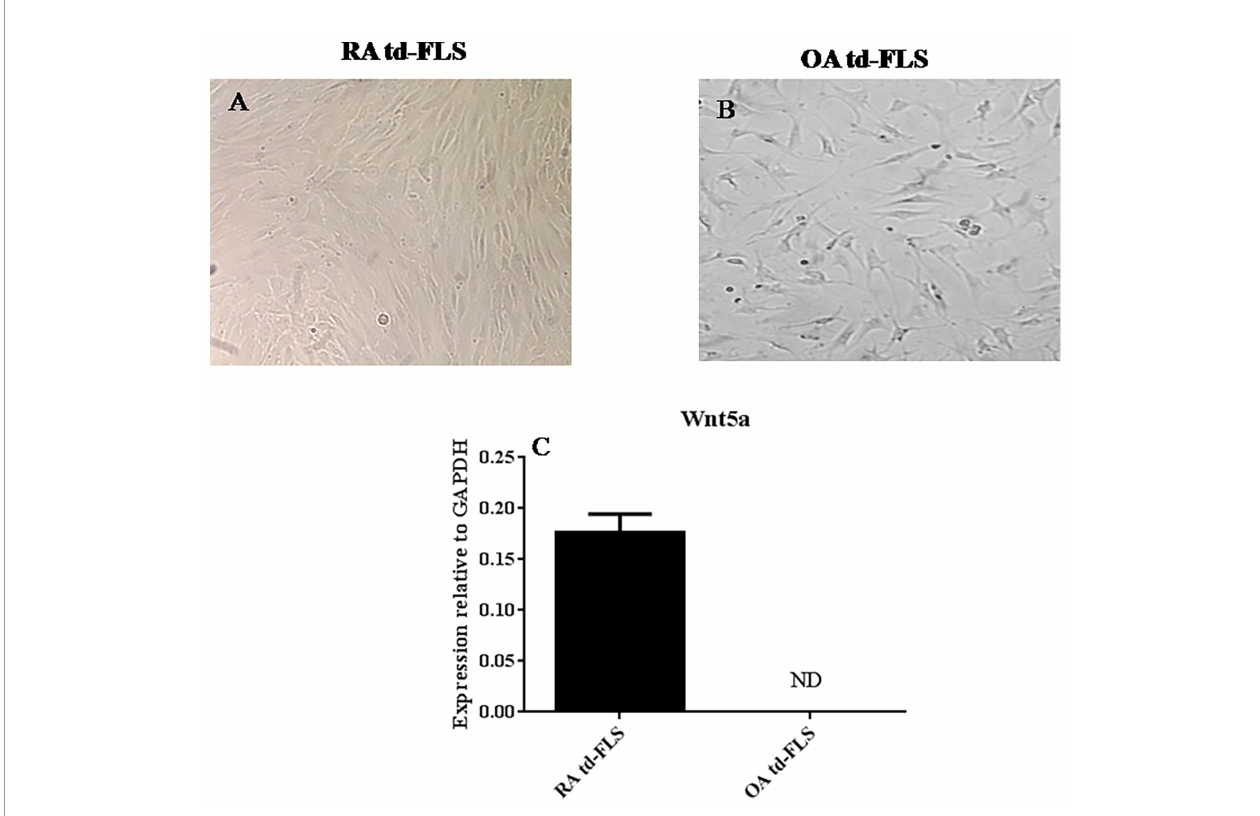
FIGURE 1 | Comparison of Wnt5a expression in td-FLS from patients with RA and OA: Third passage RA td-FLS (A) . Third passage OA td-FLS (B) . Wnt5a mRNA expression in RA td-FLS (n=3) and OA td-FLS (n=3) (C) . Wnt5a was expressed in RA td-FLS but not in OA td-FLS. ND, Not detected. Results are shown as the mean ±